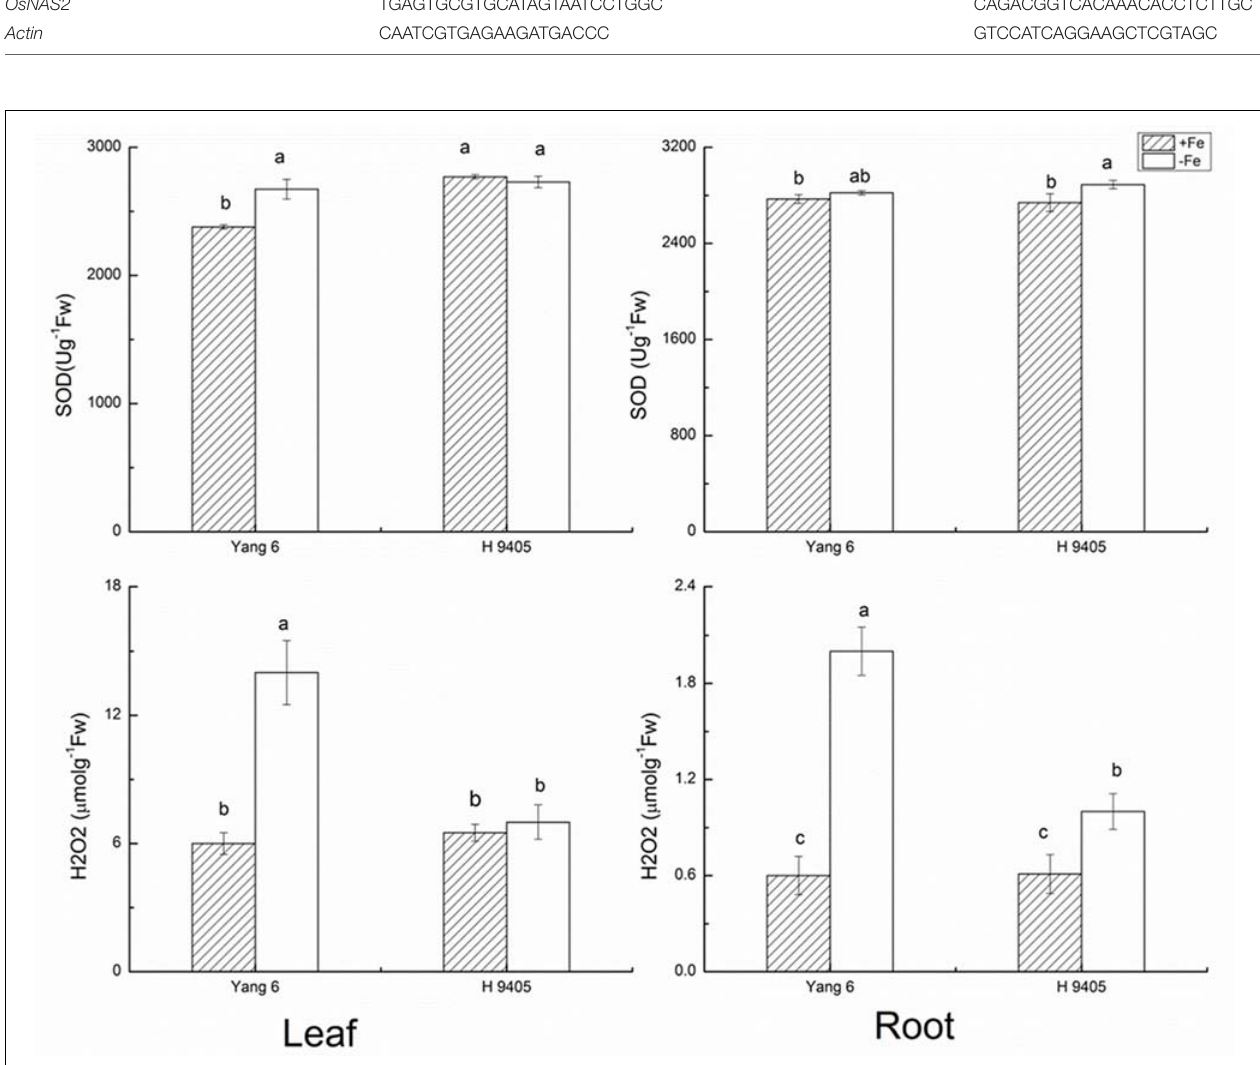
FIGURE 1 | Effects of iron deficiency on SOD and H 2 O 2 contents in leaves and roots of rice seedlings. Data are presented as means ± SE of three biological replicates. Significant differences among treatments are indicated by different letters as determined by Duncan’s test ( P < 0.05).